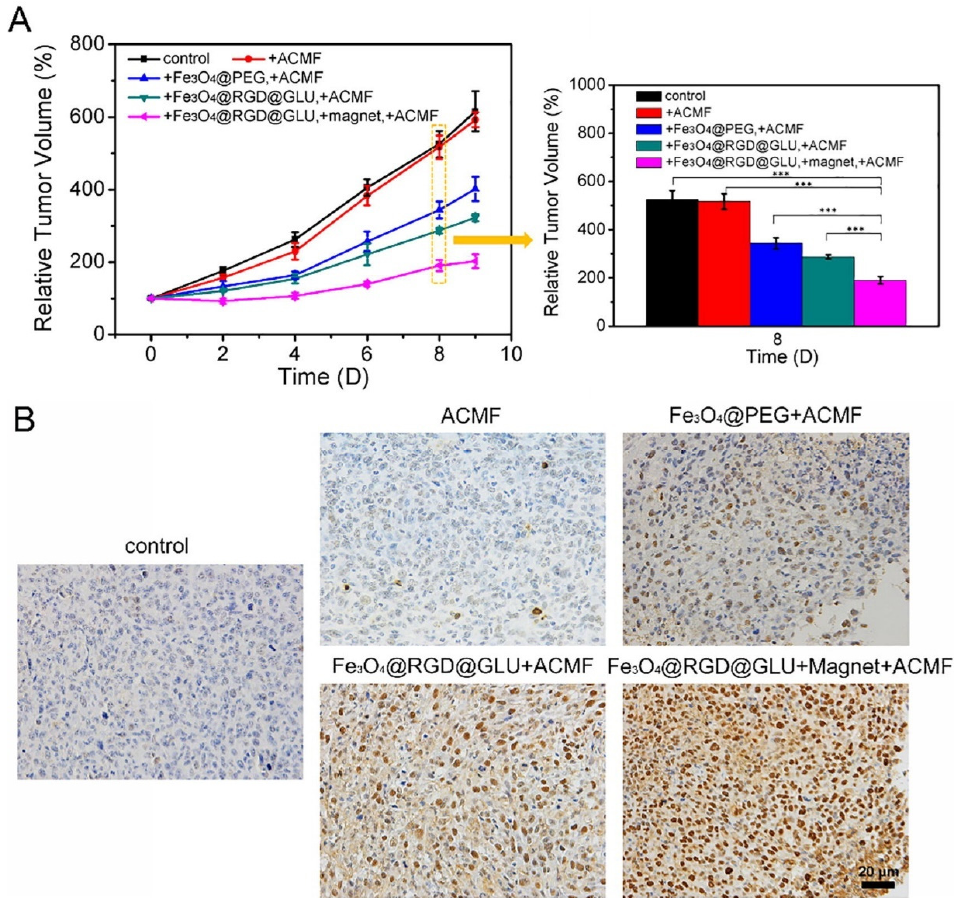
Figure 3. Analysis of the tumor growth curves for 10 days after treatment with iron oxide nano ‐ materials, mean ± SE and n = 5 ( A ). TUNEL histological analysis of mice tumors at day 9. Statistical significance is represented by the asterisk (*** p < 0.001). TUNEL assay for mice tumors on day 9 following various treatments ( B ). Reprinted with permission from [105]. Copyright (2019) Elsevier.